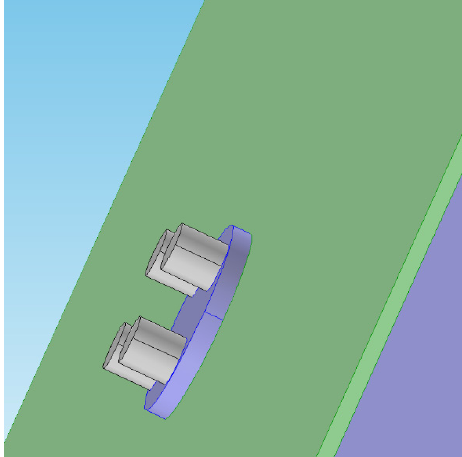
Fig.4: Cylindrical conducting layer material placed in between the electrodes and the epithelial layer. The green layer of thickness 300 µm represents an epithelial layer.